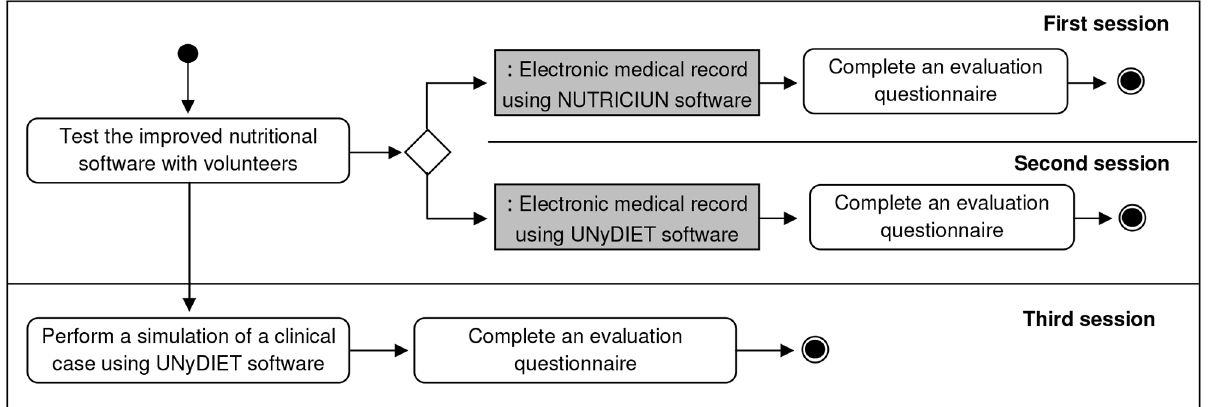
Fig 6. Activity Diagram for the Second Phase of the assessment of the